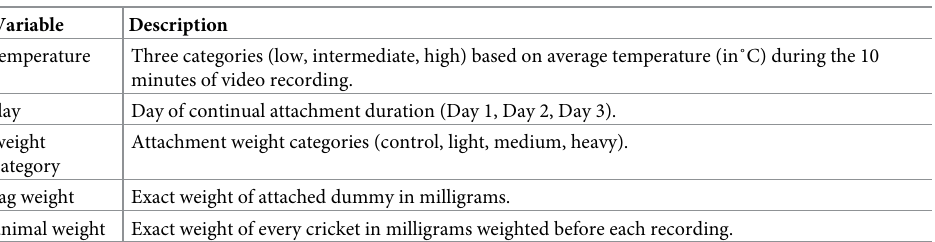
Table 2. Data captured during the